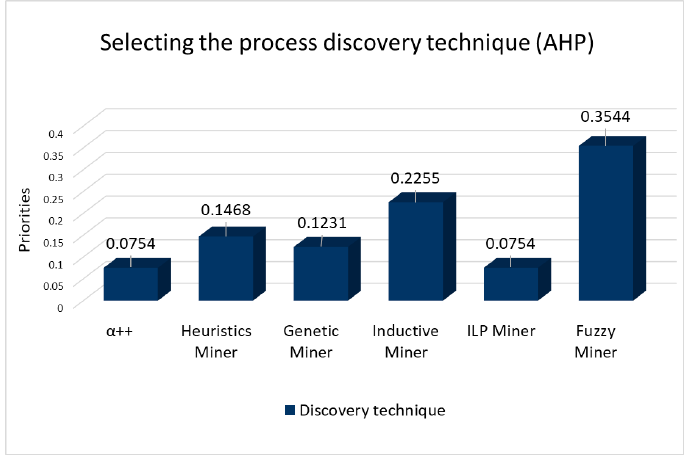
Figure 2. Selection of the process discovery technique using AHP.